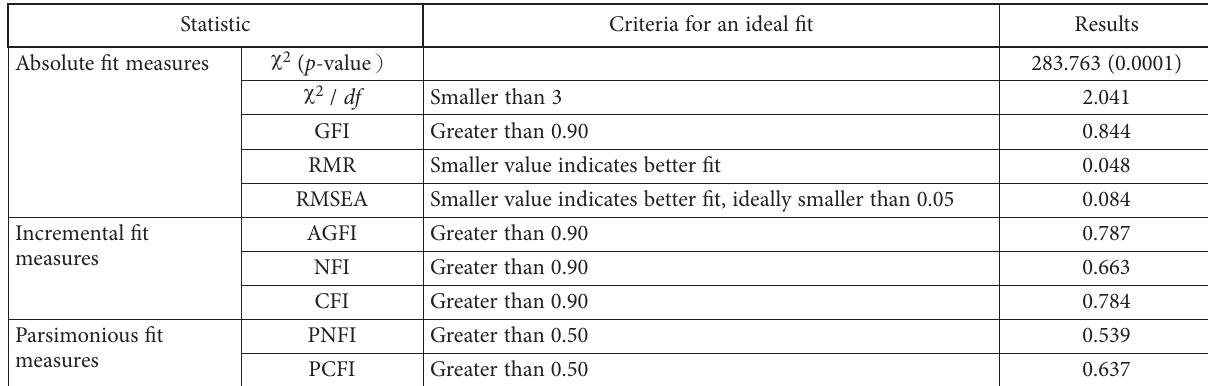
Table 6. List of fit measures of the